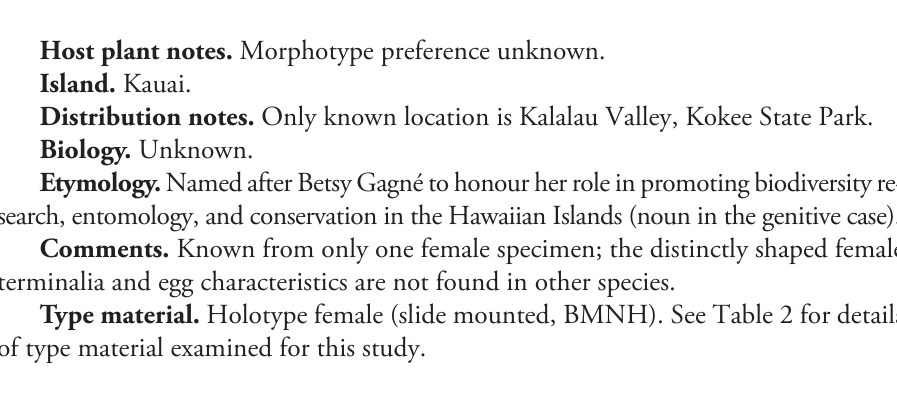
Adult colour. General body colour yellow to pale brown. Fore wing membrane clear or slightly